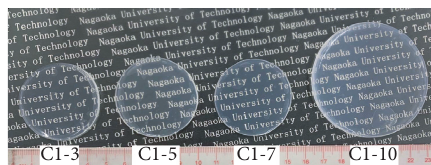
Figure 6: The appearance of the chitin hydrogels at different LiCl concentrations.